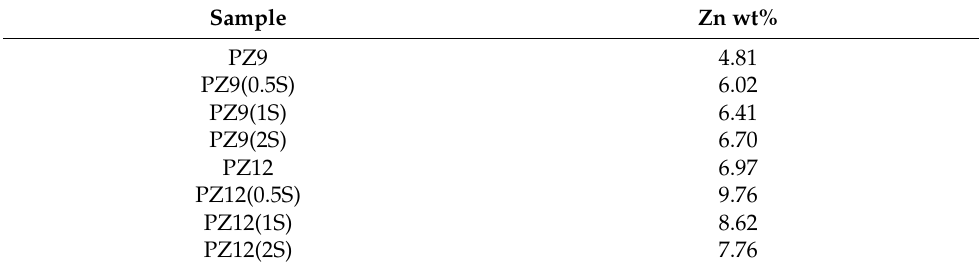
Table 4. Elemental zinc (Zn) contents of the PZ9 and PZ12 samples according to EDX analyses.